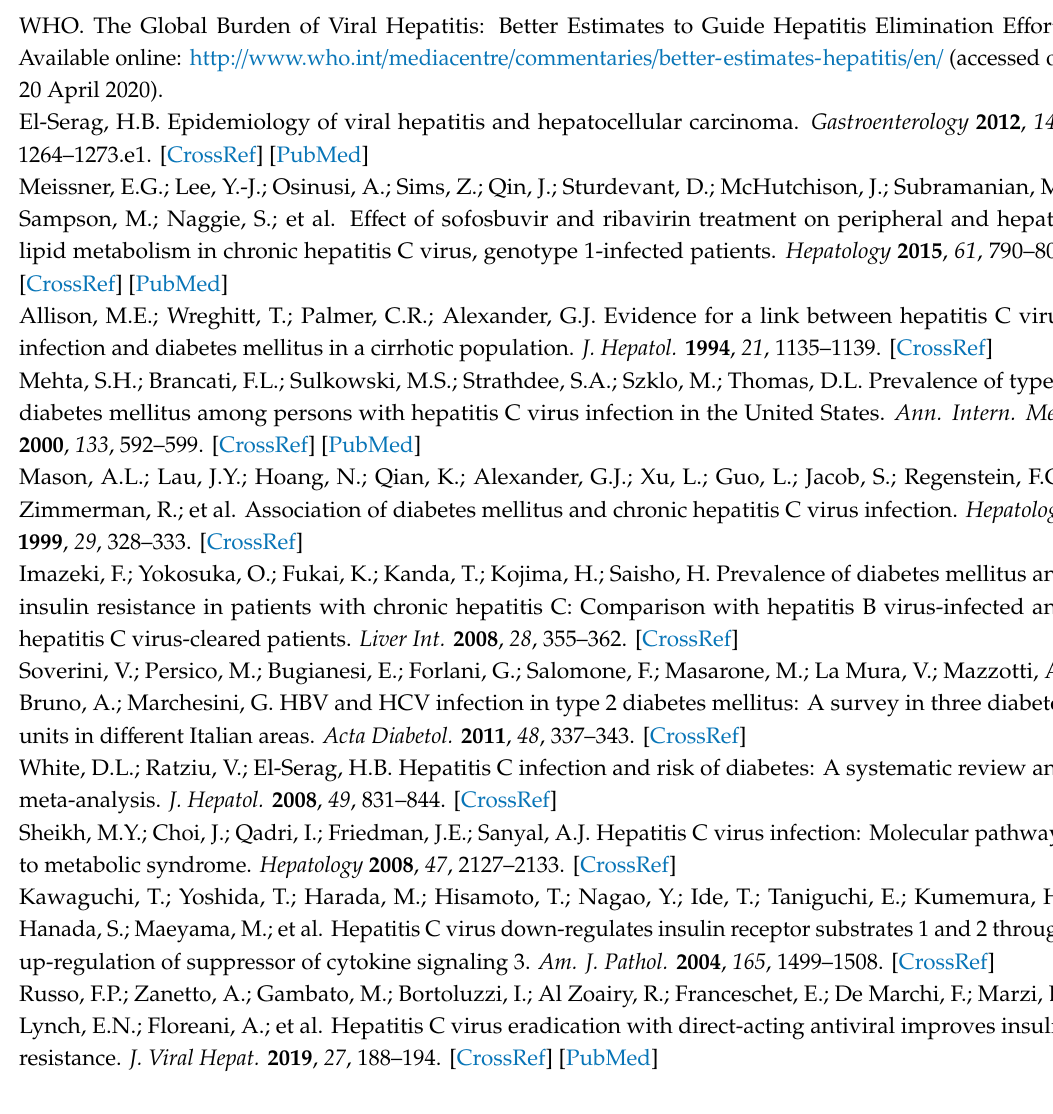
Table S1: Correlation of HOMA-IR with noninvasive liver fibrosis assessments and liver parameters, at di ff erent time points, during and after antiviral